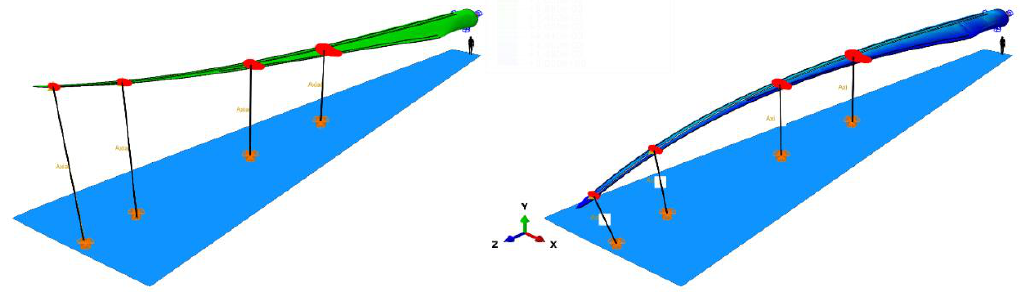
Figure 5. View of the full-scale models and static test setup, with the blade positioned for the negative flatwise load case. A drawing of a human is added for scale. ( left ) Unloaded configuration; ( right ) configuration at full load.